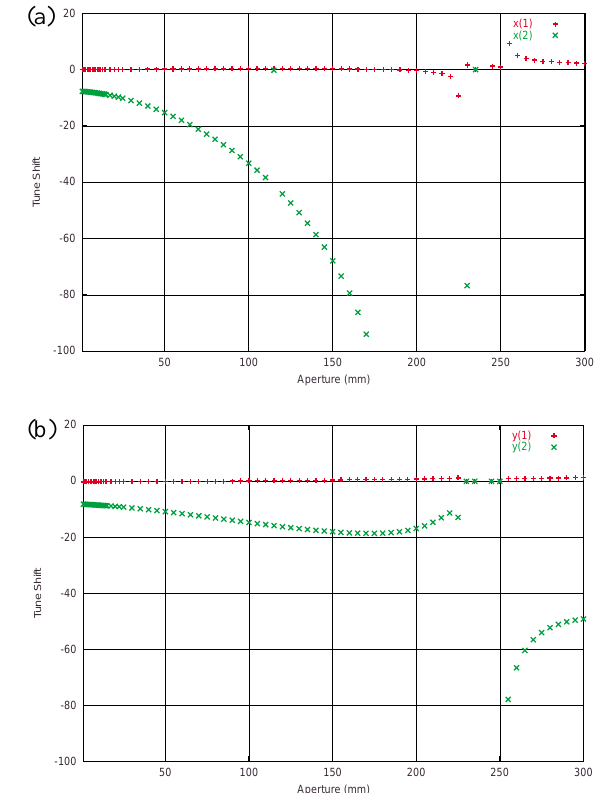
FIG. 6. (Color) (a) Same as Fig. 3 and (b) same as Fig. 4, but without the matching section, where most of the fringe field effects are